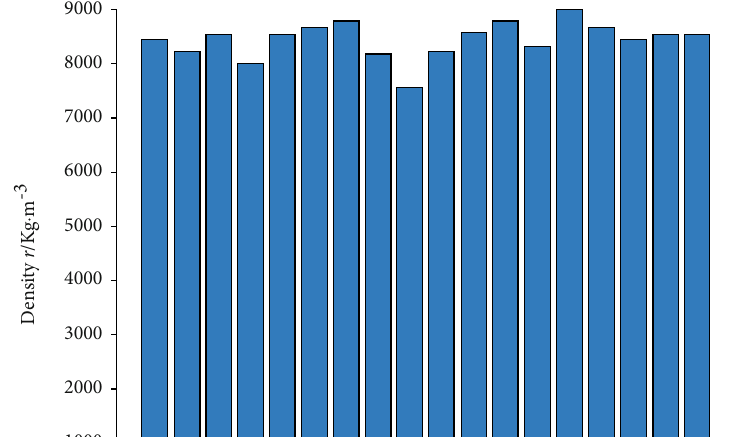
Blade Nos. Figure 1: Variation of blade elasticity modulus.